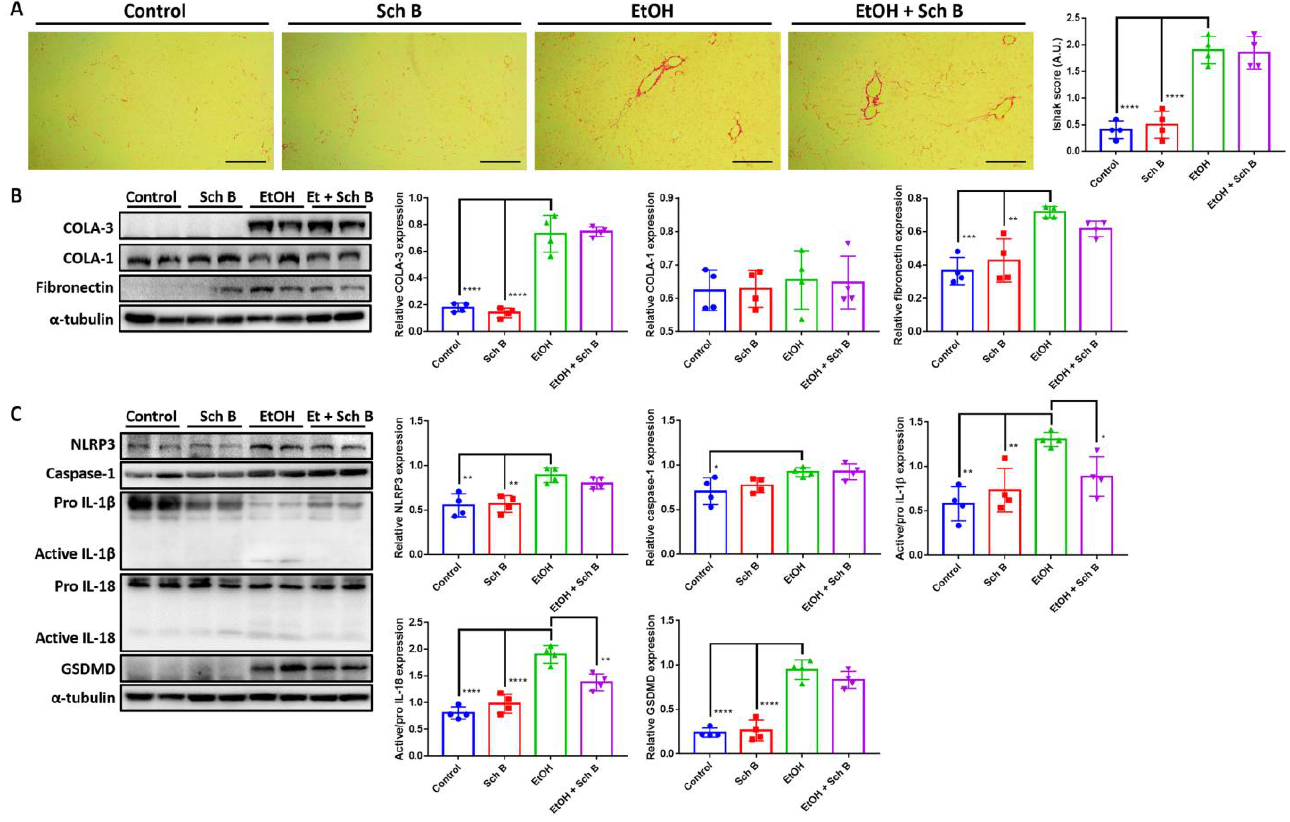
Figure 3. Schisandrin B prevents activation of liver inflammasomes in mice consuming ethanol. ( A ) Representative Sirius red-stained histological images showing collagen deposition (red color) in the livers of control, Sch B-treated, ethanol-challenged, and ethanol-challenged + Sch B-treated mice. Scale bar corresponds to 200 μm. Levels of fibrosis were quantified by Ishak score based on the Sirius red-stained slides. ( B ) Representative Western blot images and relative densitometric bar graphs of ( B ) fibrotic markers and ( C ) inflammasome components. Expression levels are standardized by α-tubulin or the pro-form protein levels as appropriate. n = 4 mice. Results are expressed as mean ± SD. * p < 0.05, ** p < 0.01, *** p < 0.001, and **** p < 0.0001.